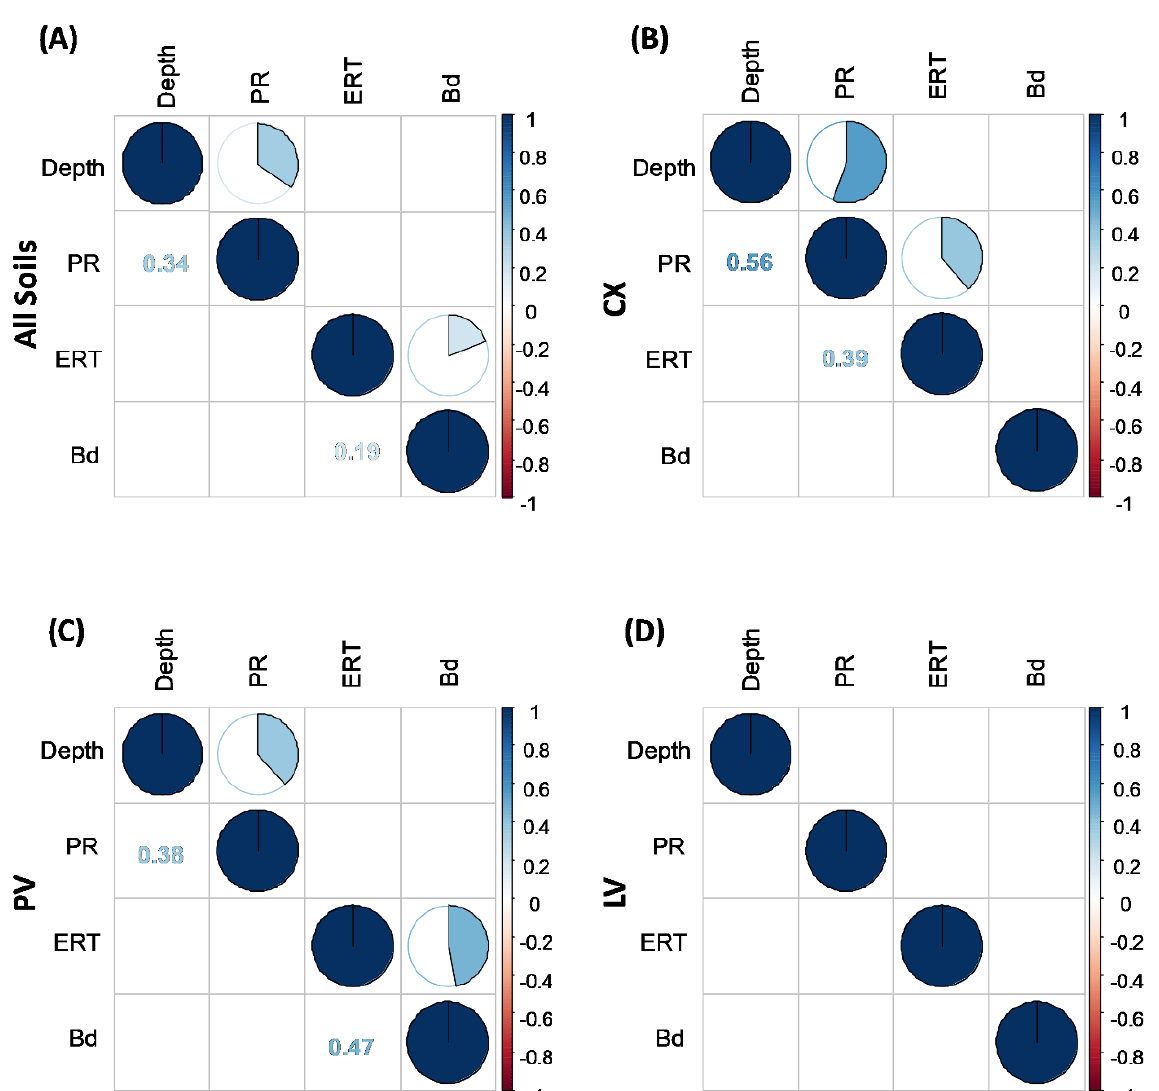
Figure 4. Representations of Pearson linear correlation coefficient for variables of sampling depth, penetration resistance (PR), soil electrical resistivity (RES), and bulk density (Bd), with data from all the soils evaluated (CX: Typic Dystrustept, PV: Rhodic Hapludult, and LV: Rhodic Hapludox) ( A ), and separately for each soil CX ( B ), PV ( C ), and LV ( D ). Only significant correlations are shown ( p < 0.05); blue circles indicate positive correlations and red circles negative correlations; the upper off-diagonal entry denotes the pie chart for the pairwise correlation level and the lower off-diagonal entry denotes the corresponding pairwise correlation